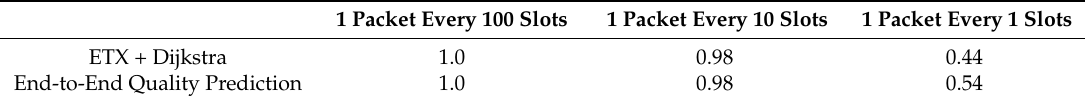
Table 2. Packet delivery ratio (PDR) under diverse load conditions.